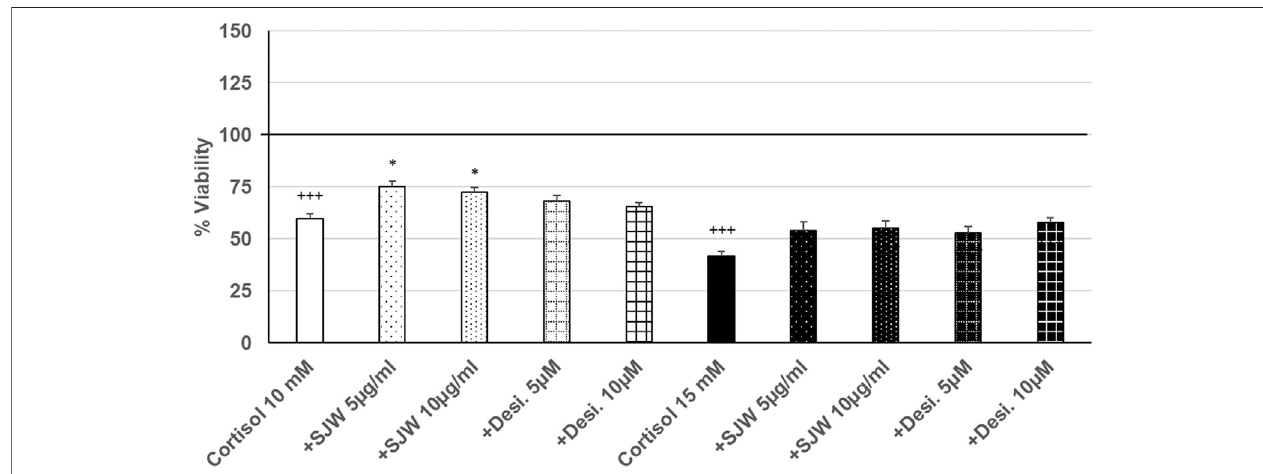
FIGURE 7 | Effects of 48 pre-treatment with STW3-VI [St. John ’ s wort (SJW)] or desipramine and afterwards 24 h co-incubation with cortisol (10 or 15 mM) on viabilityofmouseSIM-A9microglia.ViabilitywasmeasuredbyPrestoBlue ® assay.Values[in%viabilityofuntreatedcontrol(control (cid:2) 100%viability)]aregivenasmean+ SEM; signi fi cance (by T-TEST): * p ≤ 0.05, vs. cortisol; +++ p ≤ 0.001 vs. untreated control (100%); n (cid:2) 4 ‒ 12.